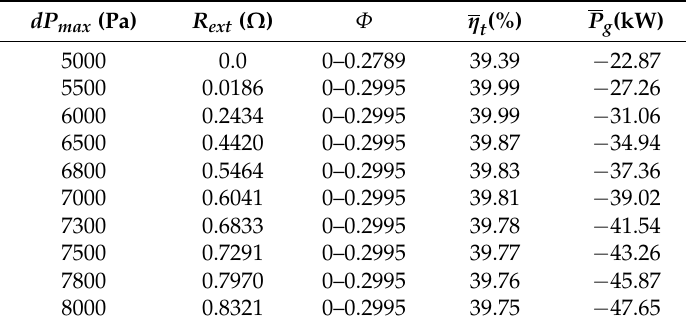
Table 4. Performance of MPPT algorithm with optimised LUT.